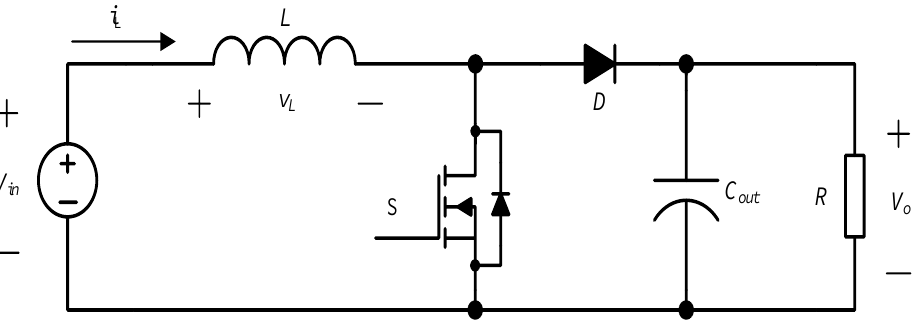
Figure 3. Circuit architecture of boost converter.